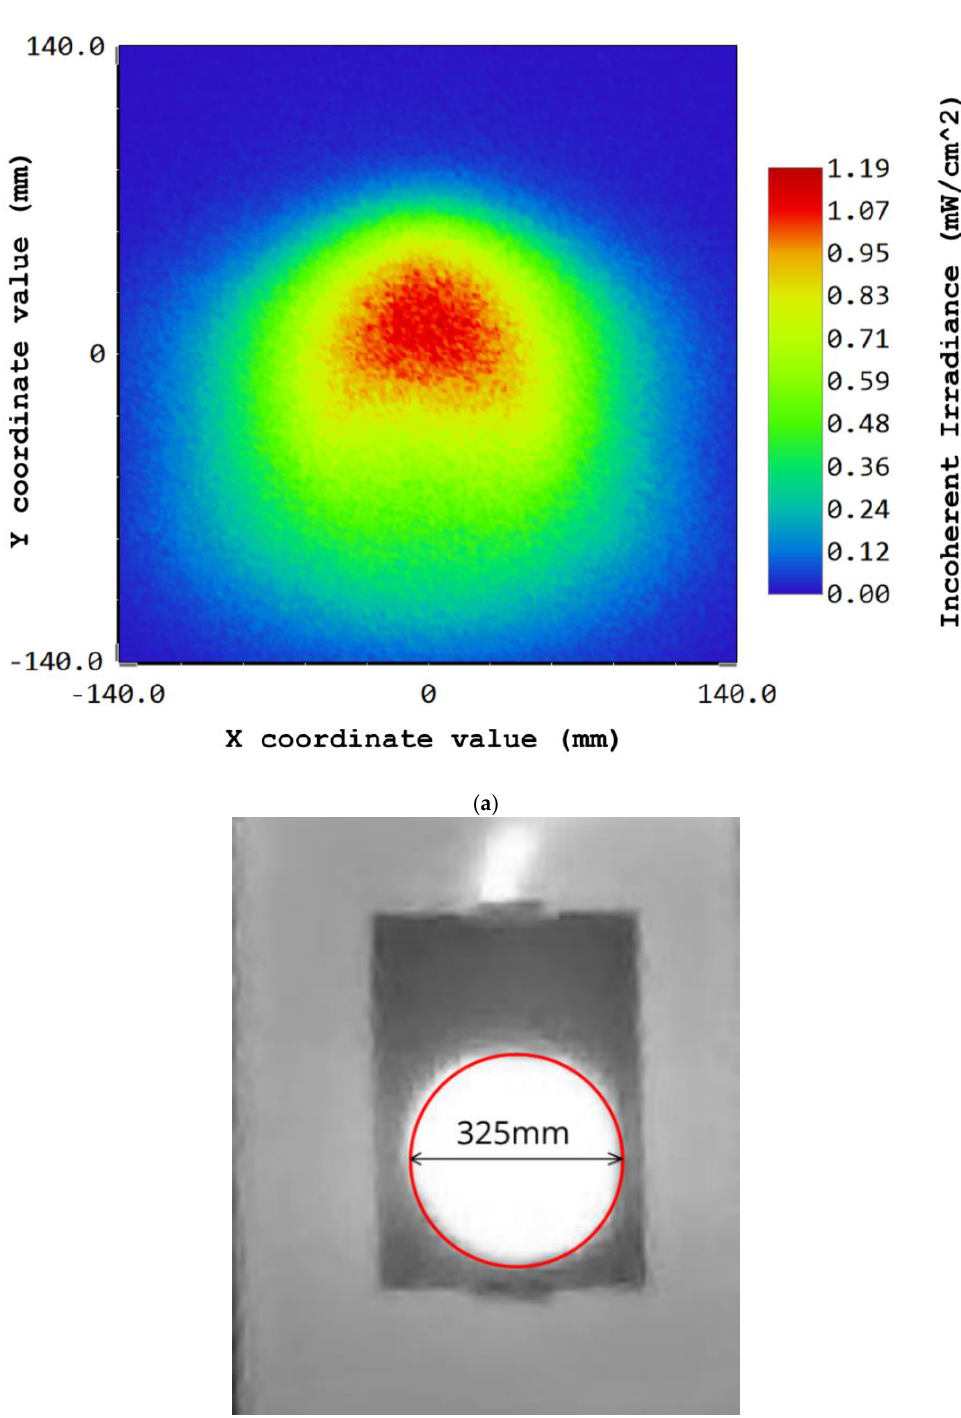
Figure 10. Beam profile at 20 m ( a ) simulated using Zemax; ( b ) captured using an infrared camera.